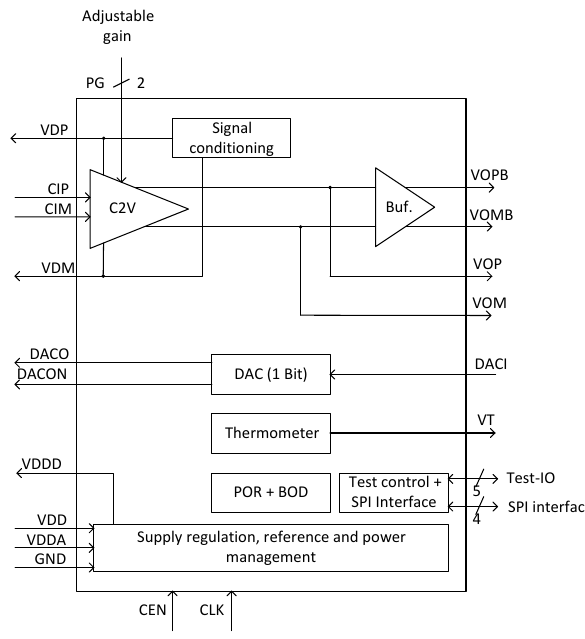
Figure 5. Block level schematic of the complete readout ASIC.